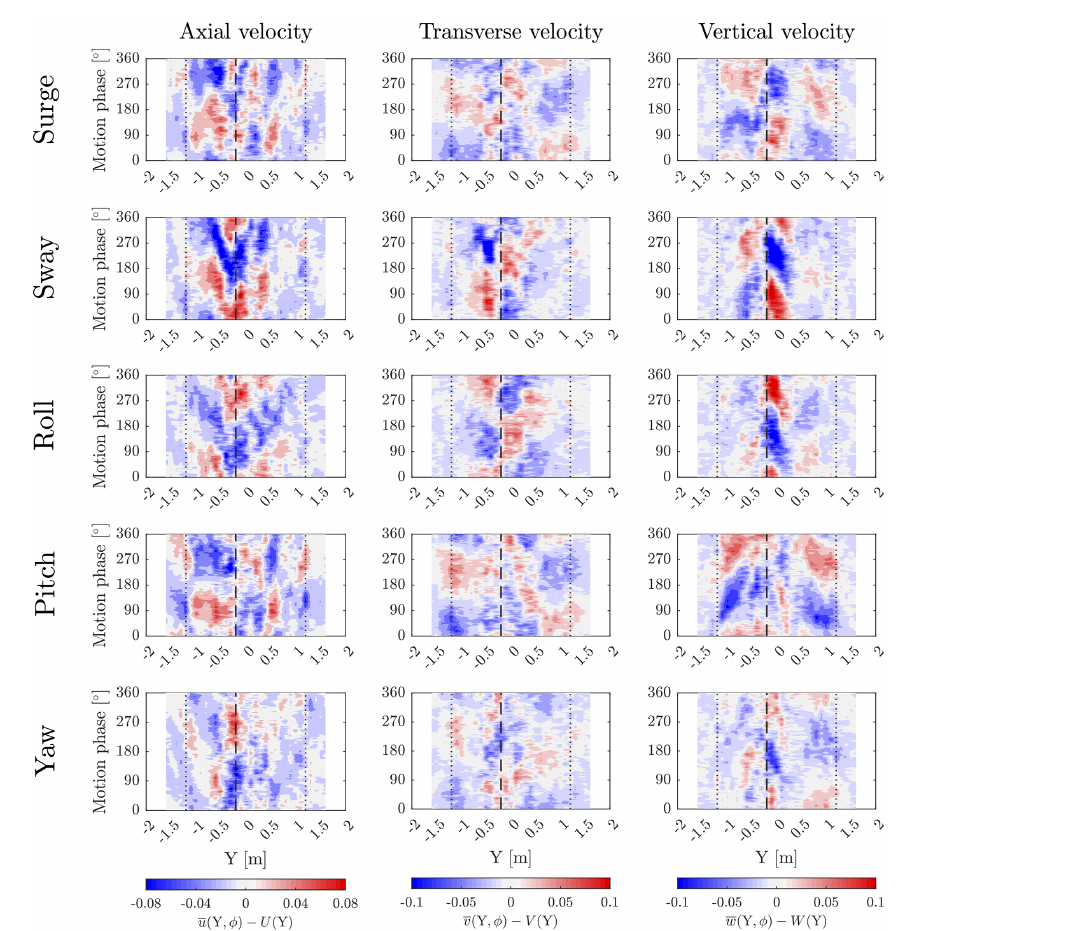
Figure 9. Space-time evolution of phase-averaged wake velocities ( u ( Y,φ ) axial; v ( Y,φ ) transverse; w ( Y,φ ) vertical; φ is the motion phase): variation with respect to the mean velocity in each point ( U ( Y ), V ( Y ), W ( Y )). The results are obtained for motion at the wave frequency, for WC2, at X = 2 . 3 D . The phase averaging is done based on 94 motion cycles. The vertical dotted lines mark the edge of the rotor, and the dashed vertical line indicates the average position of the wake